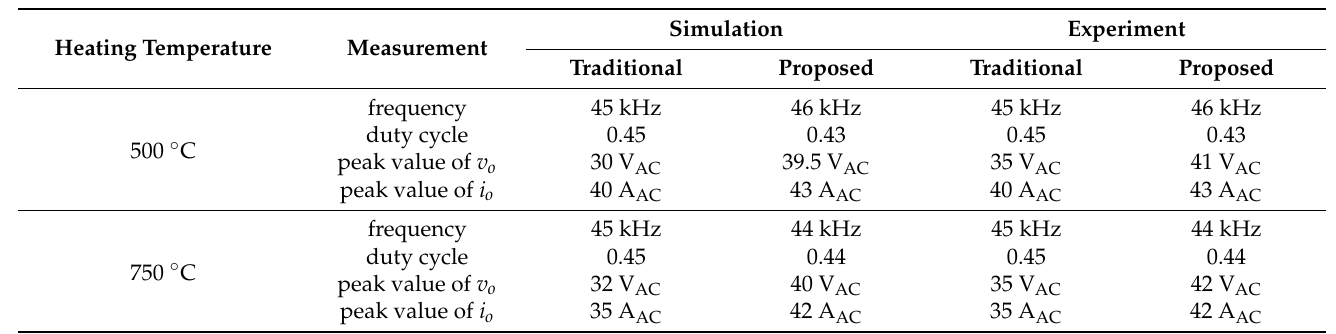
Table 5. Comparison between the simulation results and the experiment results of the proposed and the traditional control strategies.